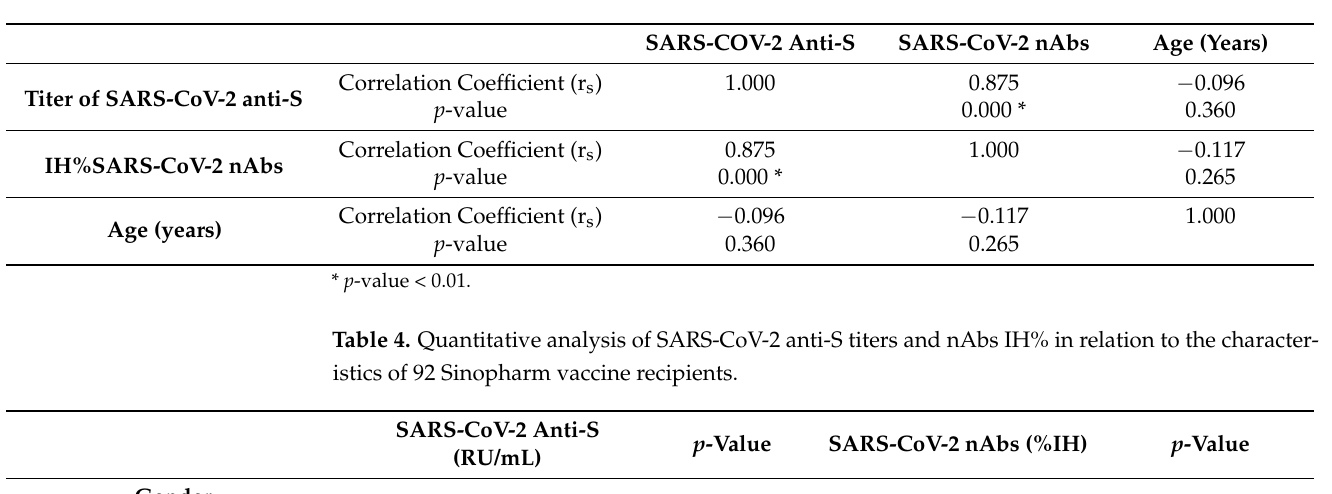
Table 3. Spearman correlation matrix determining the relation of the age with SARS-CoV-2 anti-S and IH% of nAbs among 92 Sinopharm vaccine recipients.